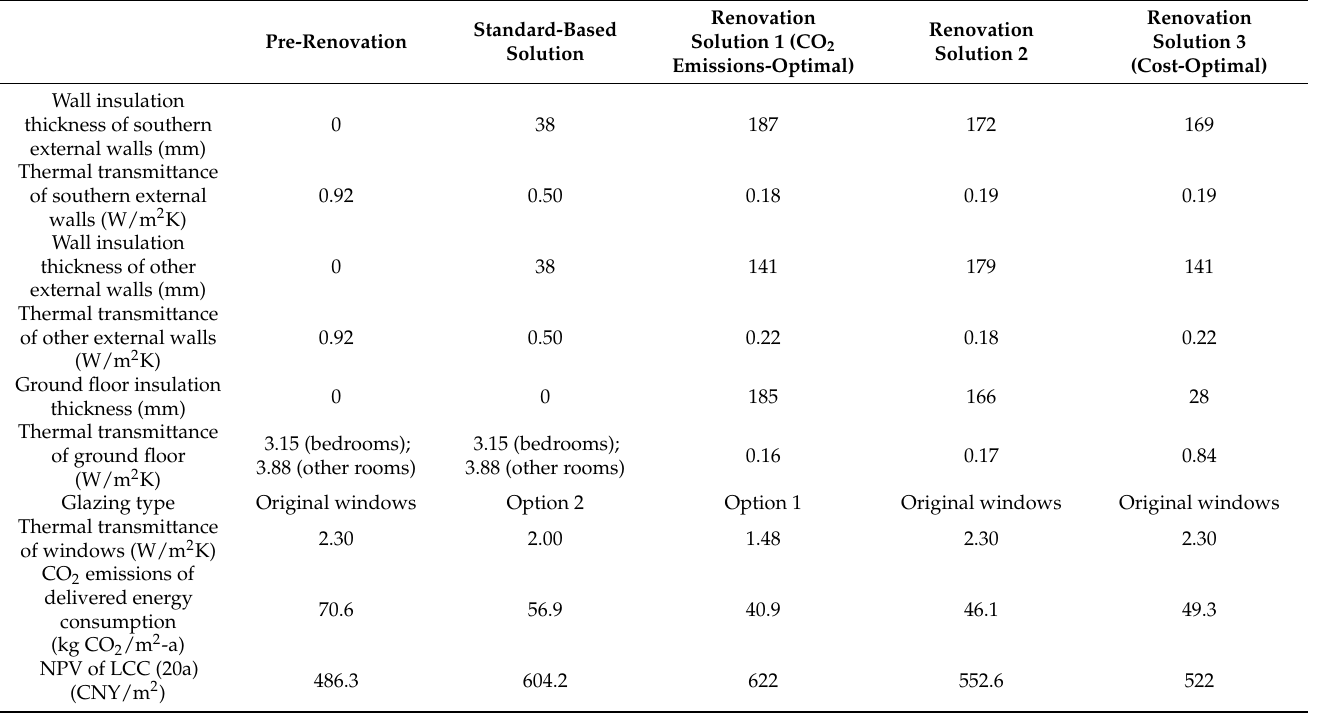
Table 5. Comparison of pre-renovation cases and renovation solutions under intermittent heating mode.